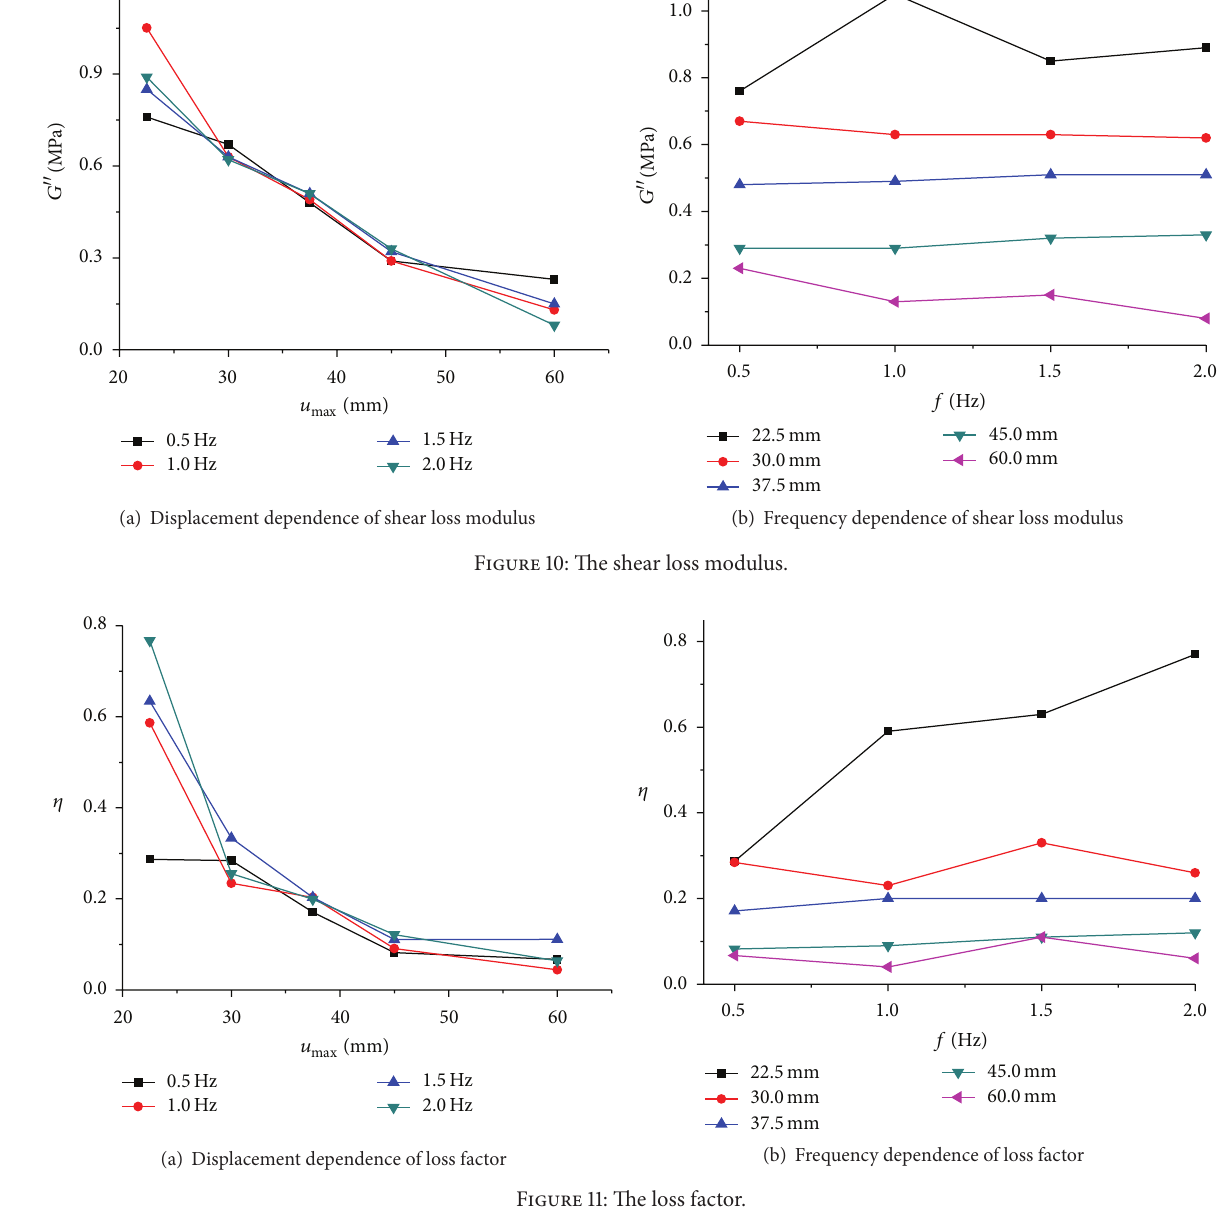
Figure 11: The loss